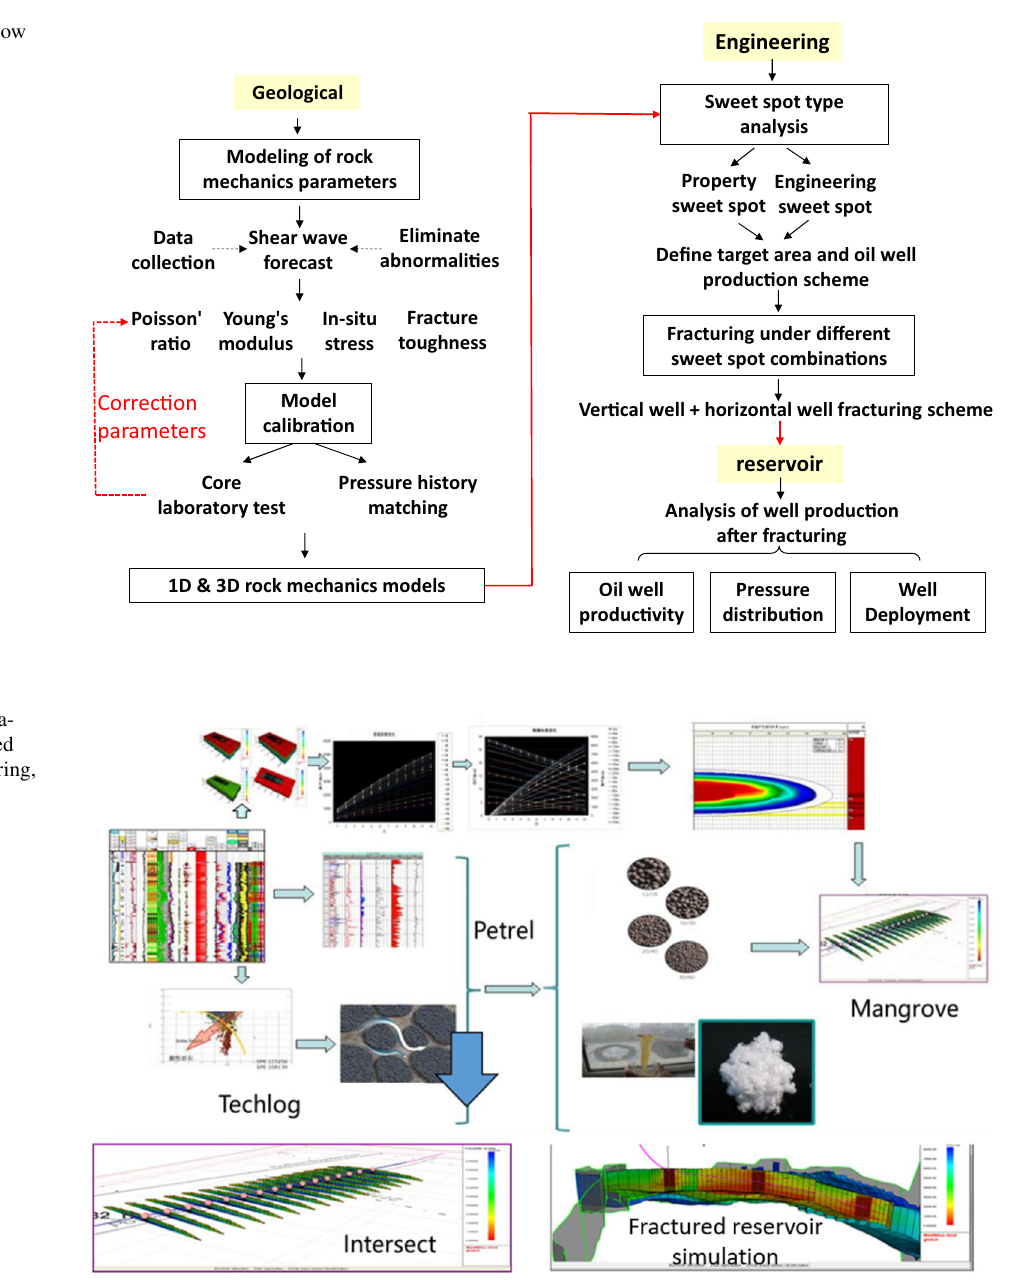
Fig. 2 the Integrated Workflow of hydraulic fracturing and reservoir modeling2